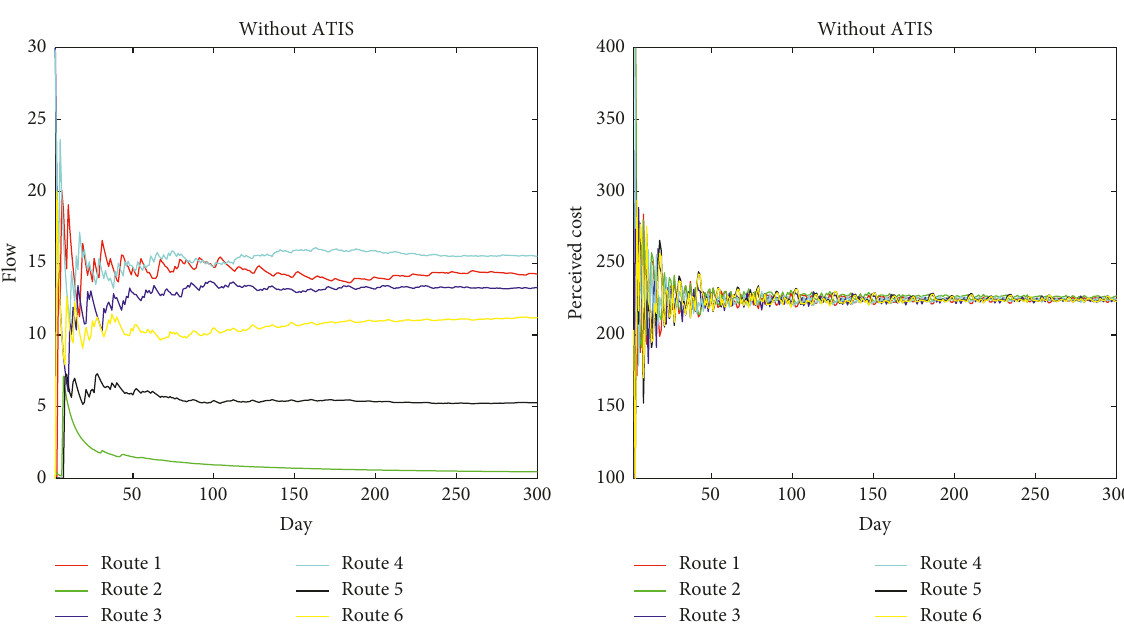
Figure 7: Evolutionary trajectories of route flows (a) and perceived travel costs (b) for travellers in the third